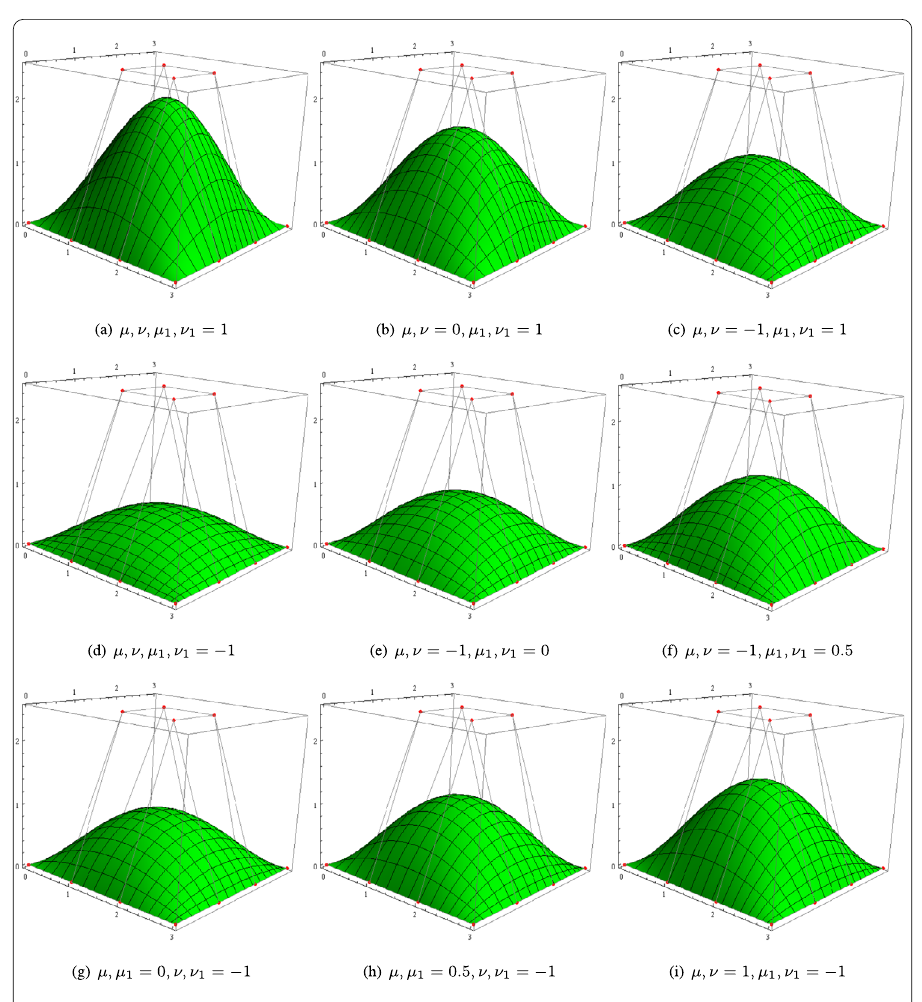
Figure 7 GBT-Bézier bi-linear surfaces with different shape parameters